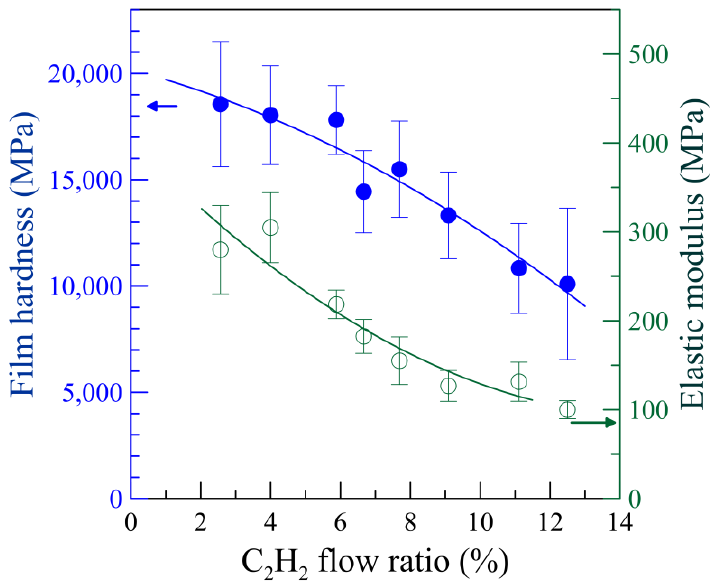
Figure 6. Mean values and standard deviations for nanoindentation hardness (H) and elastic mod- ulus (E) for Cr–C films deposited on the Si (100) substrate with a substrate bias of −150 V at 0.8 Pa deposition atmosphere with different C 2 H 2 gas fractions.